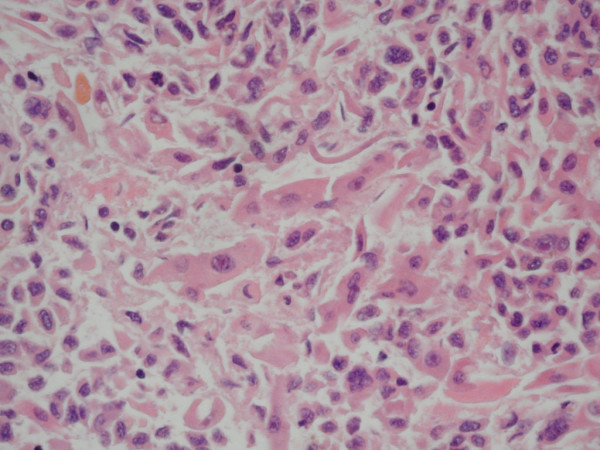
Liver biopsy contains numerous neoplastic elongate cells consistent with malignant melanoma infiltration.